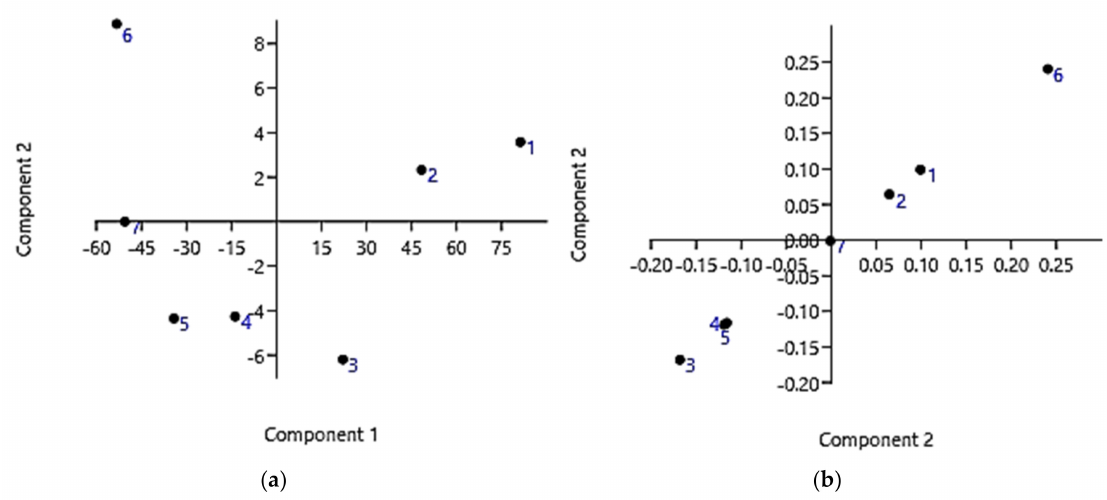
Figure 7. PCA results on data covering 24 h of cells exposure: score plot showing data locations of PC1 vs. PC2 ( a ); score plot showing data locations of PC2 vs. PC2 ( b